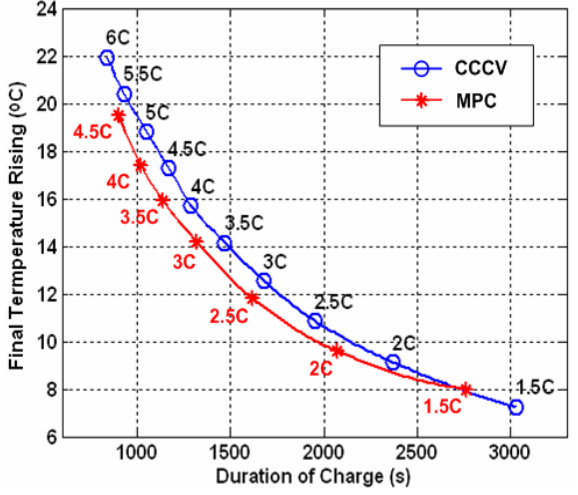
Figure 8. Pareto fronts of CCCV and MPC charging methods in simulation. The expected trajectories of MPC are modified from CCCV by multiplying